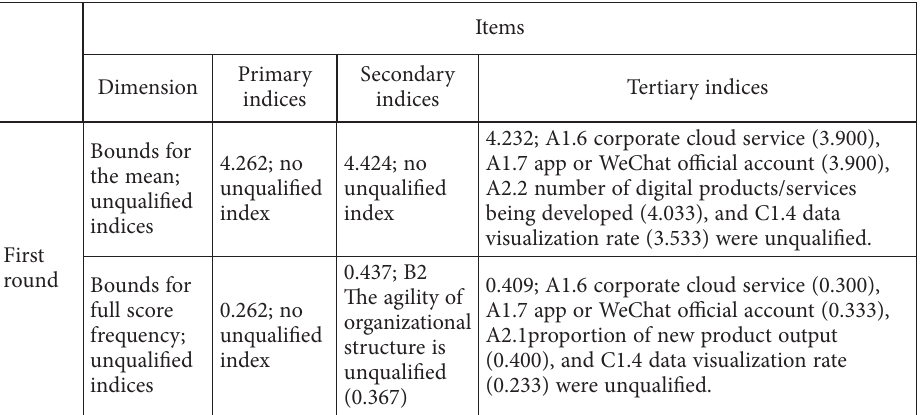
Table 8. Index adjustment by boundary value